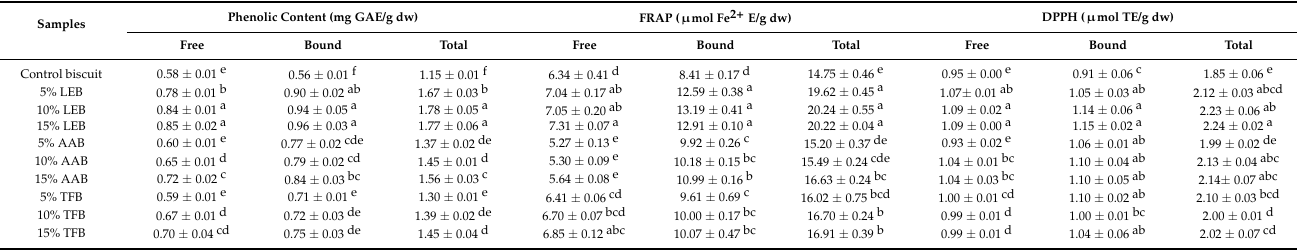
Values = means ± standard deviation ( n = 3). Values in the same column with different letters are significantly different ( p < 0.05). Total = Free + Bound for phenolic content, FRAP and DPPH. LEB— L. edodes biscuit; AAB— A. auricula biscuit; TFB— T. fuciformis